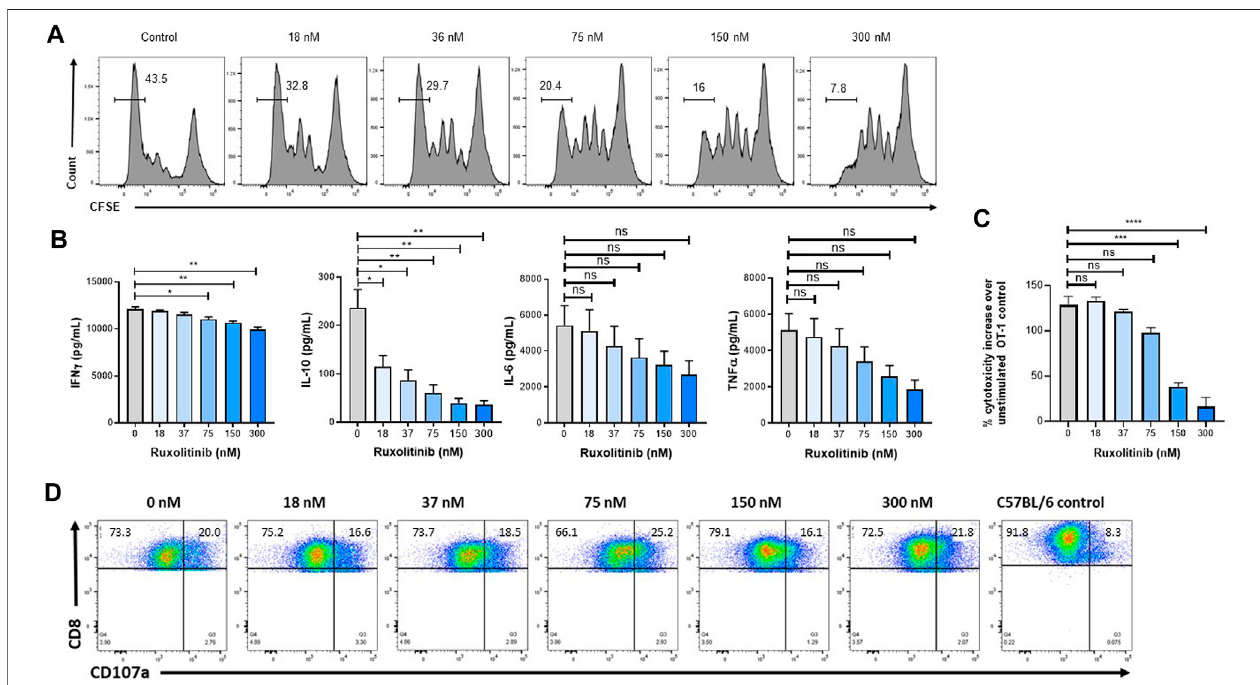
FIGURE3| RuxolitinibreducesproliferationwithoutaffectingeffectorfunctionofT-cells.TomeasureOT-1CD8 + T-cellexpansion,CFSE-labeledsplenocyteswere stimulated with SIINFEKL peptide and increasing ruxolitinib concentrations (A) Four days later, the number of divisions was calculated by fl ow cytometry (B) Supernatants were collected from the cultures and cytokines were quanti fi ed (C) To measure degranulation, OT-1 cultures were stimulated overnight with OVA- expressing EG-7 cells, and CD107a levels were measured by fl ow cytometry (D) OT-1 cultures were activated with OVA peptide and incubated with OVA- expressing EG-7 cells transfected with a luciferase plasmid, with luciferase activity being measured to quantify cytotoxicity. Data are representative of two independent experiments. * p < 0.05, ** p < 0.01. ** p < 0.001. ns indicates not signi fi